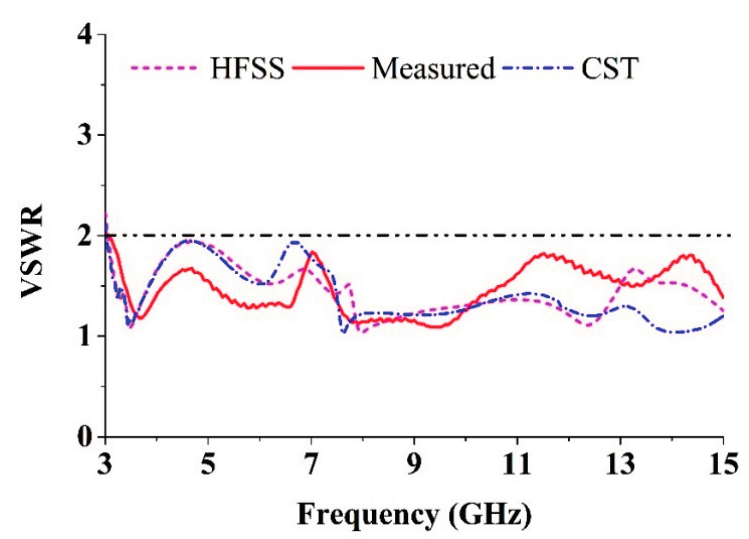
Figure 14. Agilent N5227A PNA Network Analyzer.